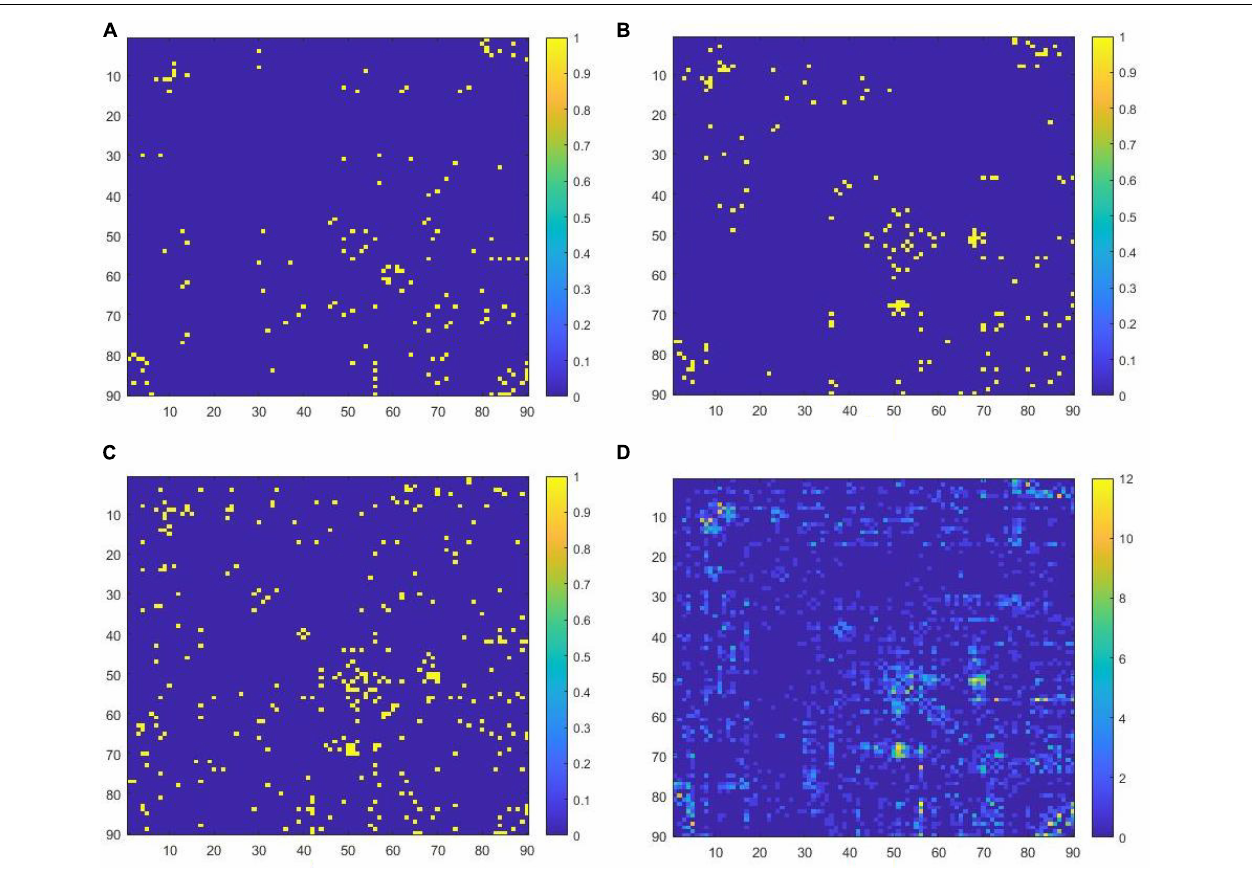
TABLE 3 | Accuracy of constructing ELM classifier with full amount of features or key features with different weights. Criteria for feature selection